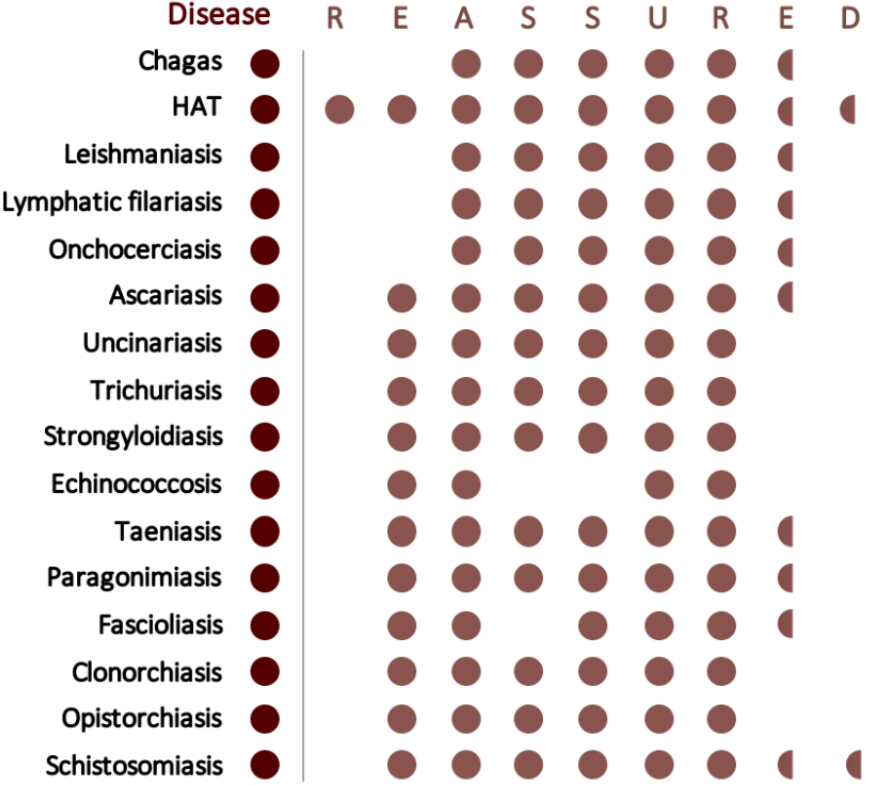
Figure 5. REASSURED criteria fulfillment of designed LAMP methods for the different parasite-caused NTDs. Red dots indicate that a criterion is fulfilled for the corresponding disease. Absence of dot means that criterion is not yet accom- plished. Half-dots signify that steps have been taken to achieve those features; however, they are not yet met. An assay is considered sensitive with 75% or more clinical sensitivity. An assay is considered specific if no cross-reaction take place with other human infecting parasites. Dracunculiasis and scabies are excluded of this figure due to lack of sufficient infor- mation.